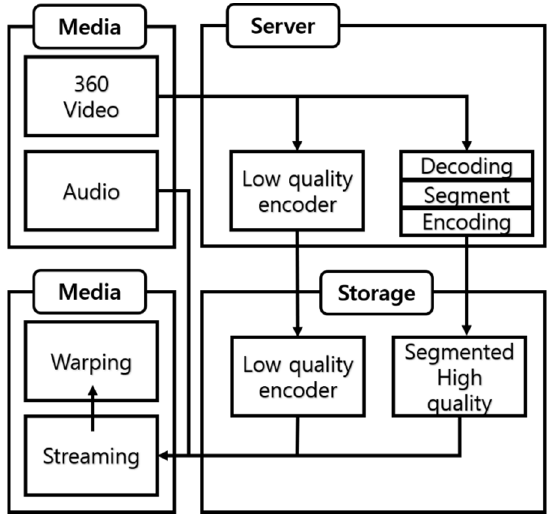
Figure 11. Media pre-processing for the FBF algorithm.